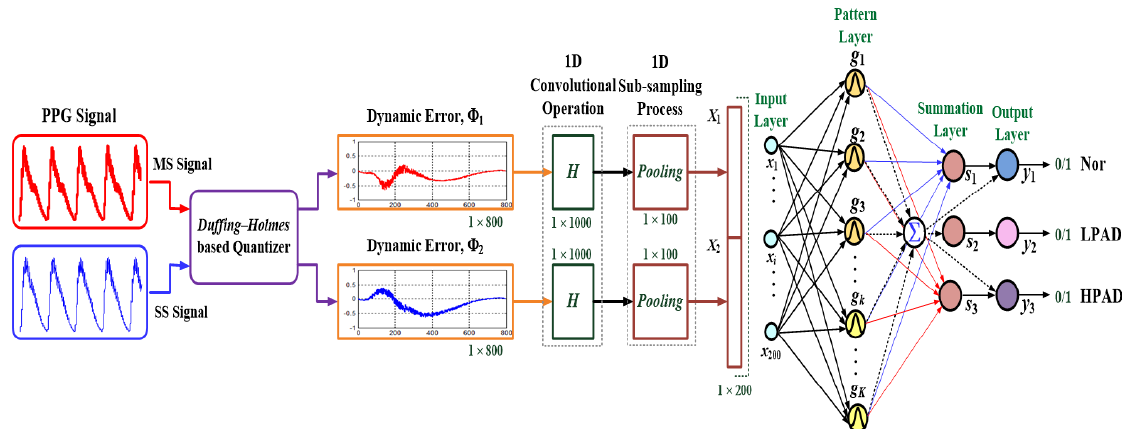
Figure 5. Configuration of the proposed 1D CNN-based classifier consisting of the D–H-based quantizer, 1D convolution operations, 1D subsampling processes, and a multilayer classifier.